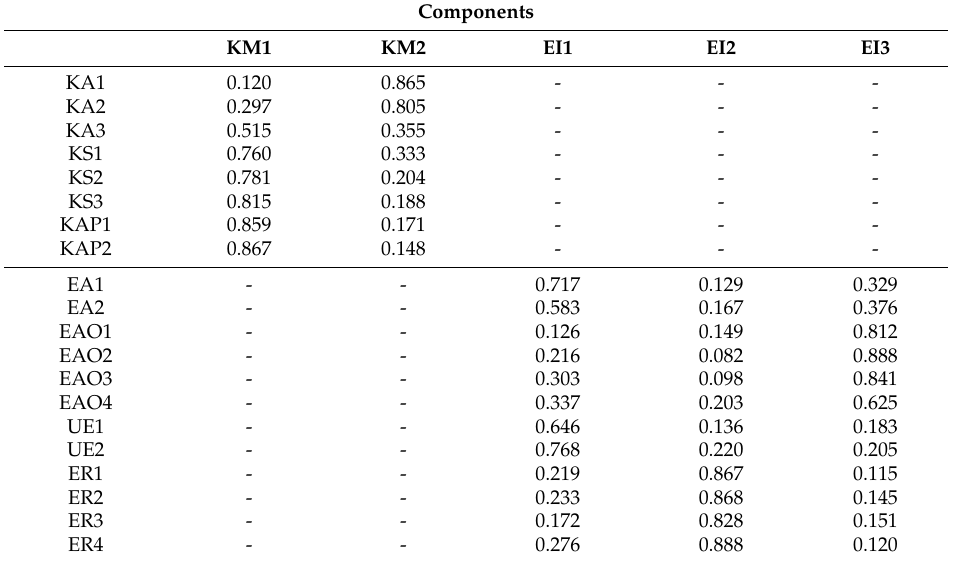
Table 3. Rotated Components Matrix.